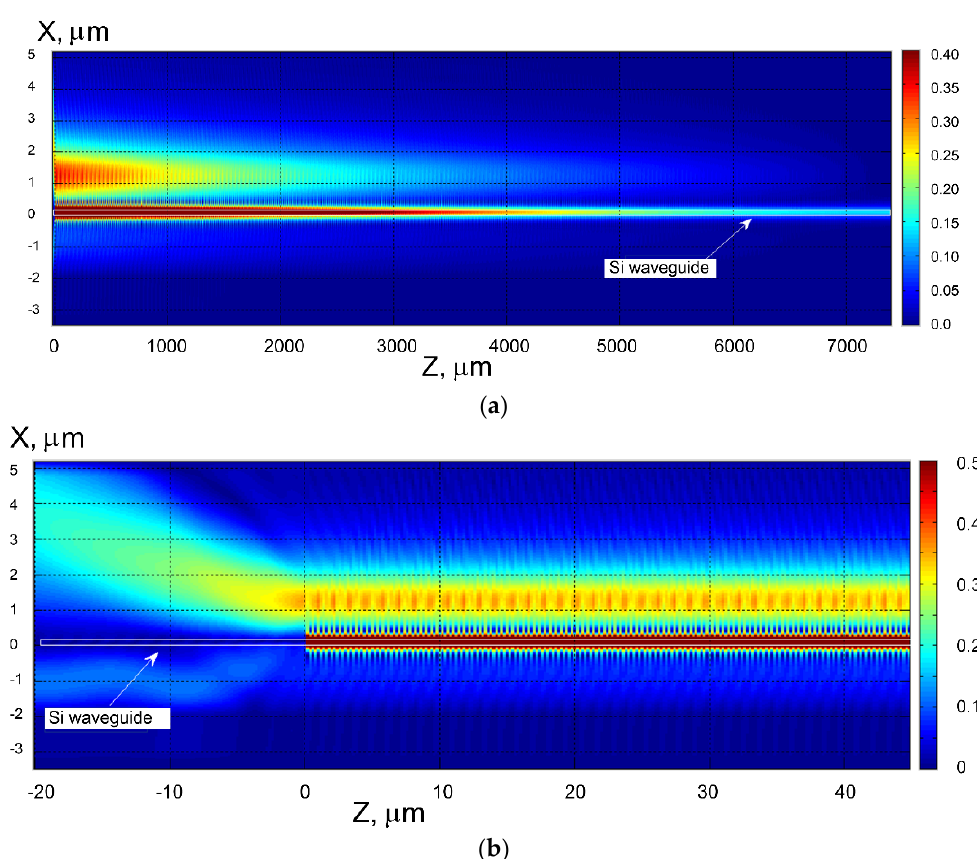
Figure 20 . Illustration of the abnormal blocking effect for back diffraction. ( a ) Total structure view; ( b ) enlarged portion of the right part of the structure. Here the segmented grating period is 1.2 µm, the number of polymer segments M = 6144, the evanescent gap d = 0.25 µm. The thickness of the silicon wire is 0.22 µm. The case of vertical segment boundaries ( d 1 = d 2 = 0.6 µm). Analysis made using 2D MoL plus EIM.